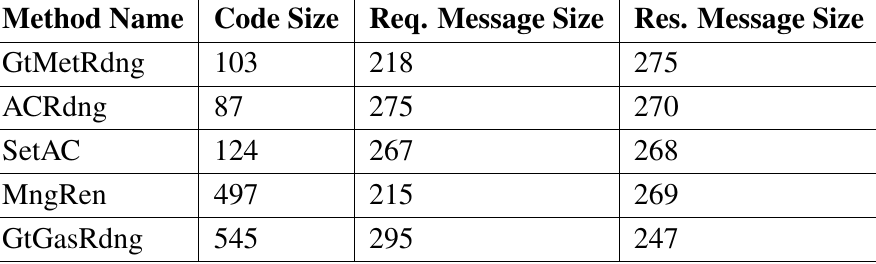
Table 1. The code & message sizes